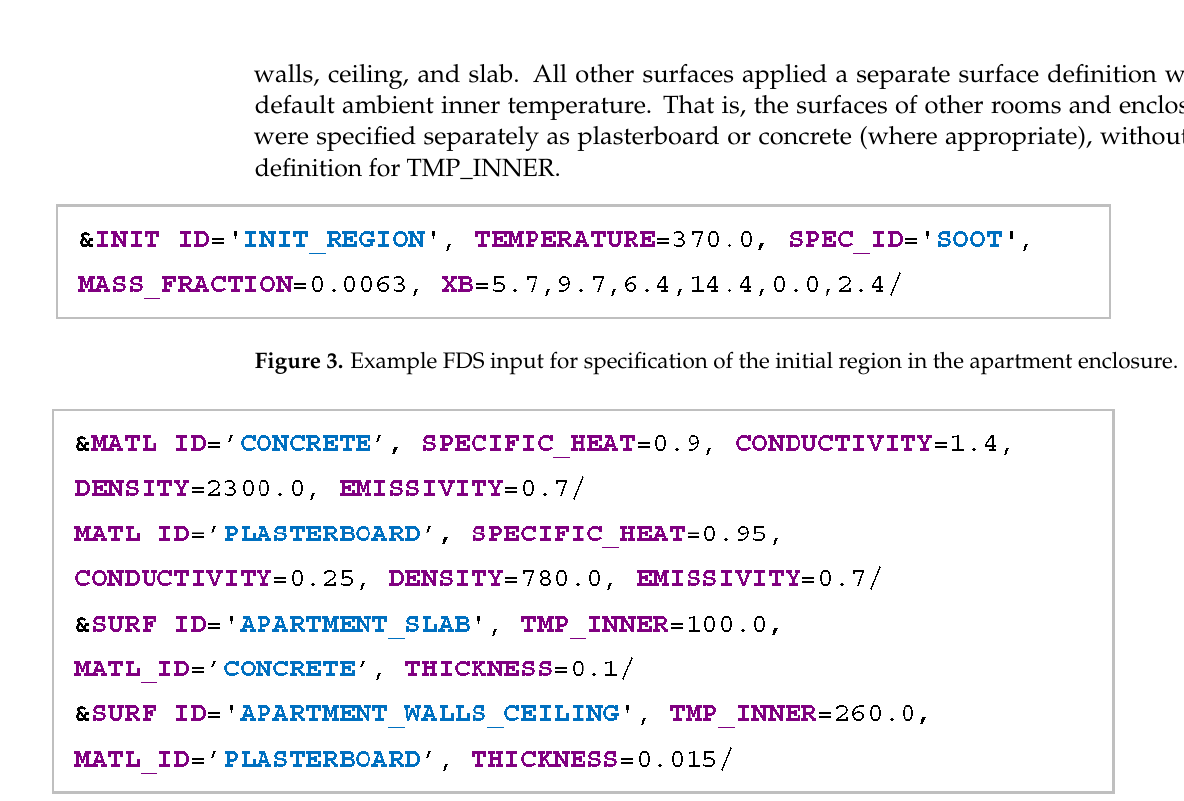
Figure 4. Example FDS input for definition of inner temperatures of apartment walls, ceilings, and slabs.